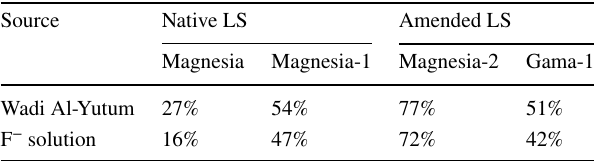
Table 5 Fluoride adsorption efficiency from Wadi Al-Yutum and F −